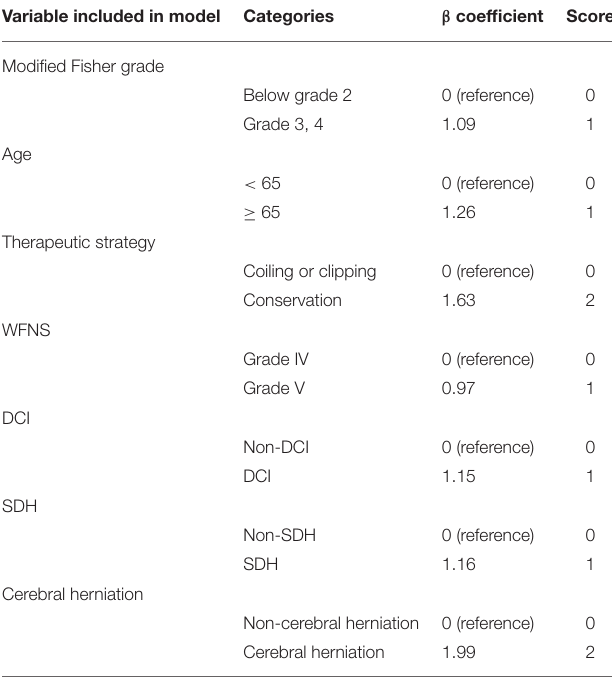
TABLE 3 | Poor-Grade Aneurysmal Subarachnoid Hemorrhage Prognostic Scoring System (PASHPSS) derived from the β coefficients. Variable included in model Categories